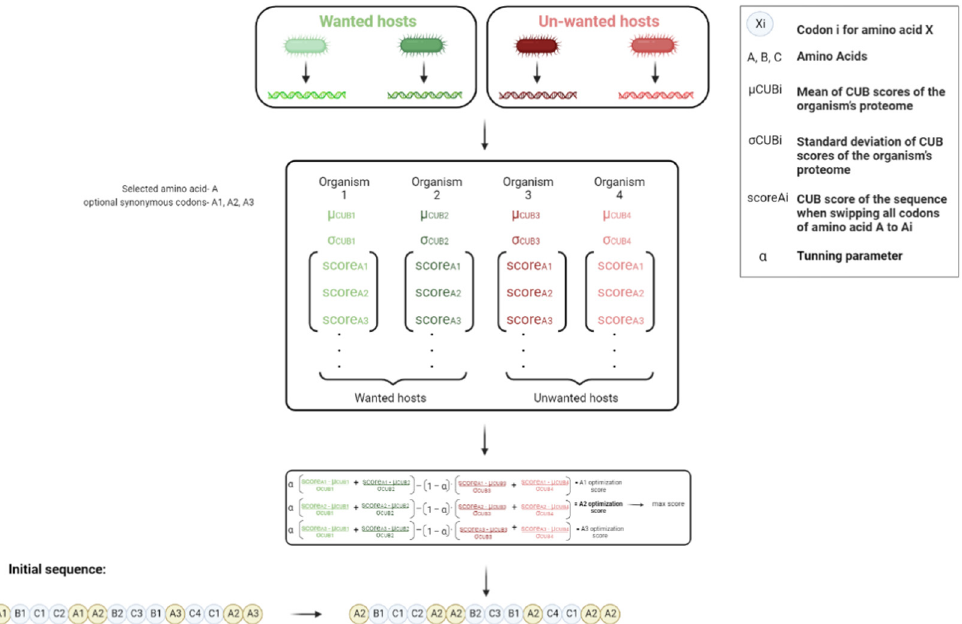
Figure 4. Translation efficiency selective enhancement, describing one hill climbing iteration of the translation optimization algorithm. The first step is to define the wanted and un-wanted hosts. The second step is to calculate the CUB score of each organism for all codons of amino acid A to Ai ( score Ai ) and then calculate the mean ( µ CUBi ) and the standard deviation ( σ CUBi ) of the CUB scores. Finally, an optimization score is calculated for each synonymous codon. All the amino acid codons in the initial sequence are switched to the codon with the maximal optimization score as calculated.